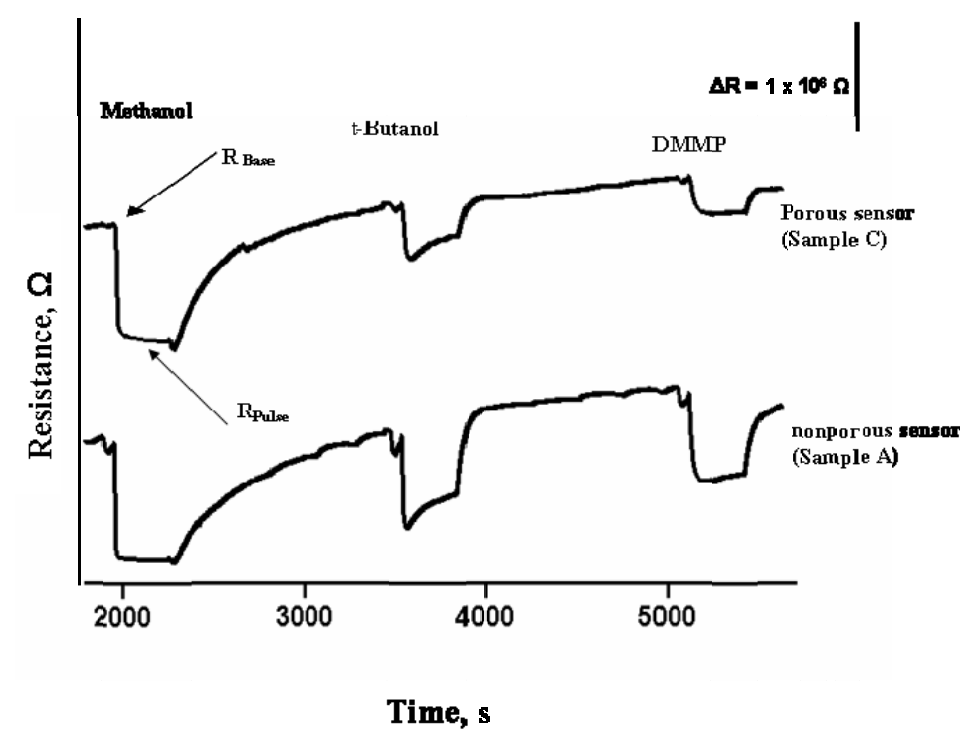
Figure 5. Sensor response to a three pulse sequence of methanol, t-butanol and DMMP for samples A and C based sensors. (Reprinted from reference [285] with permission from